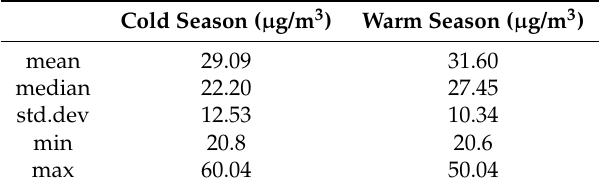
Table 3. PM coarse fraction statistics during cold and warm